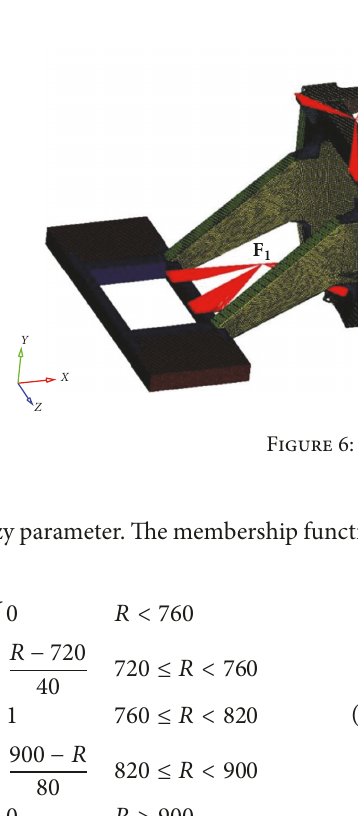
Figure 5: A freely supported beam.